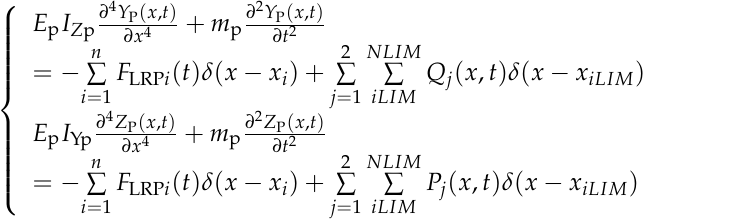
where E p and m p are the equivalent elastic modulus and mass per unit length of the sec- ondary conductive plate, respectively; I Z p and I Y p are the cross-sectional moments of iner- tia of the secondary conductive plate; Y p and Z p are the transverse and vertical displace- ments of the secondary conductive plate, respectively; F LRP i and F VRP i are the forces of the track plate on the secondary conductive plate; Q and P are the transverse and vertical electromagnetic forces, respectively; and x i is the position of the secondary conductive plate fastener pivot point. 2.3. Wheel-Rail Interaction System 2.3.1. Wheel-Rail Spatial Contact Geometry Model [17,18] The wheel traces are generated from the motion parameters of the wheelset and the tread pro fi le, and the new rail pro fi le is generated by the motion parameters of the rail and the rail pro fi le. Then the minimum vertical distance between the wheel traces and the new rail pro fi le is found as the wheel-rail contact point by transverse scanning. As the wheels run, the motion parameters of the wheels and rails change, which a ff ects the wheel traces and the new rail pro fi le, and thus the position of the wheel-rail contact point. 2.3.2. Normal Force Calculation Model